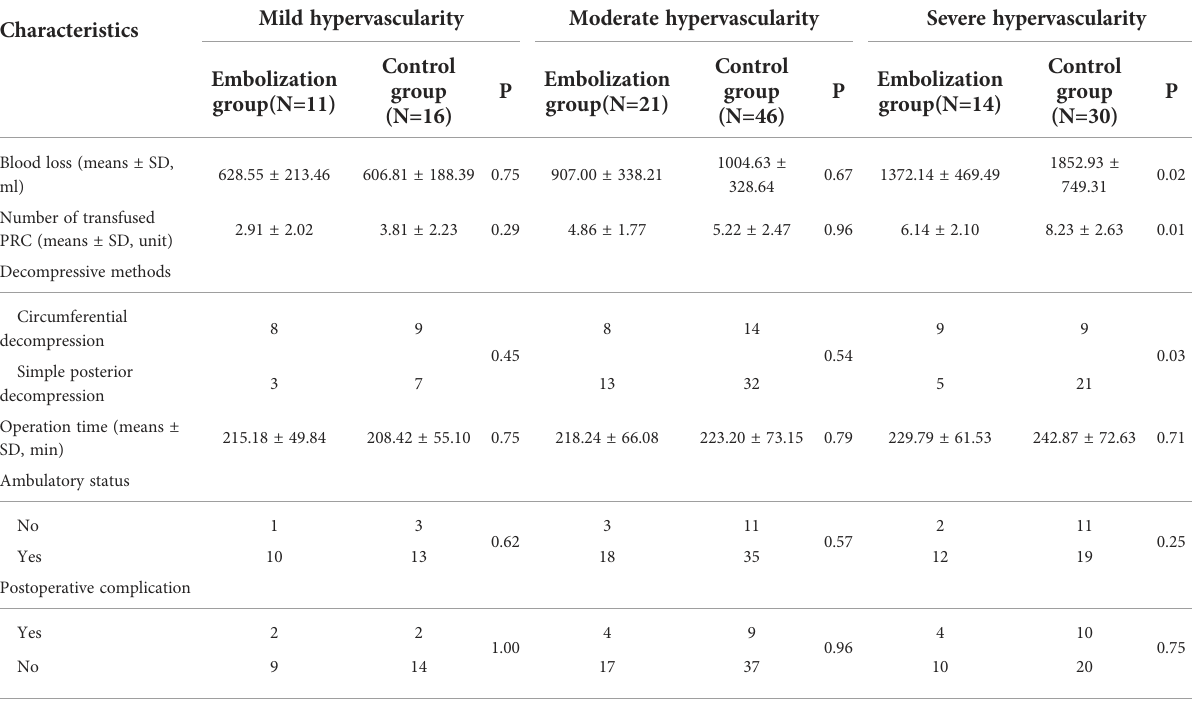
TABLE 2 Subgroup analysis of intra-operative and postoperative characteristics among patients strati fi ed by tumor vascularity.